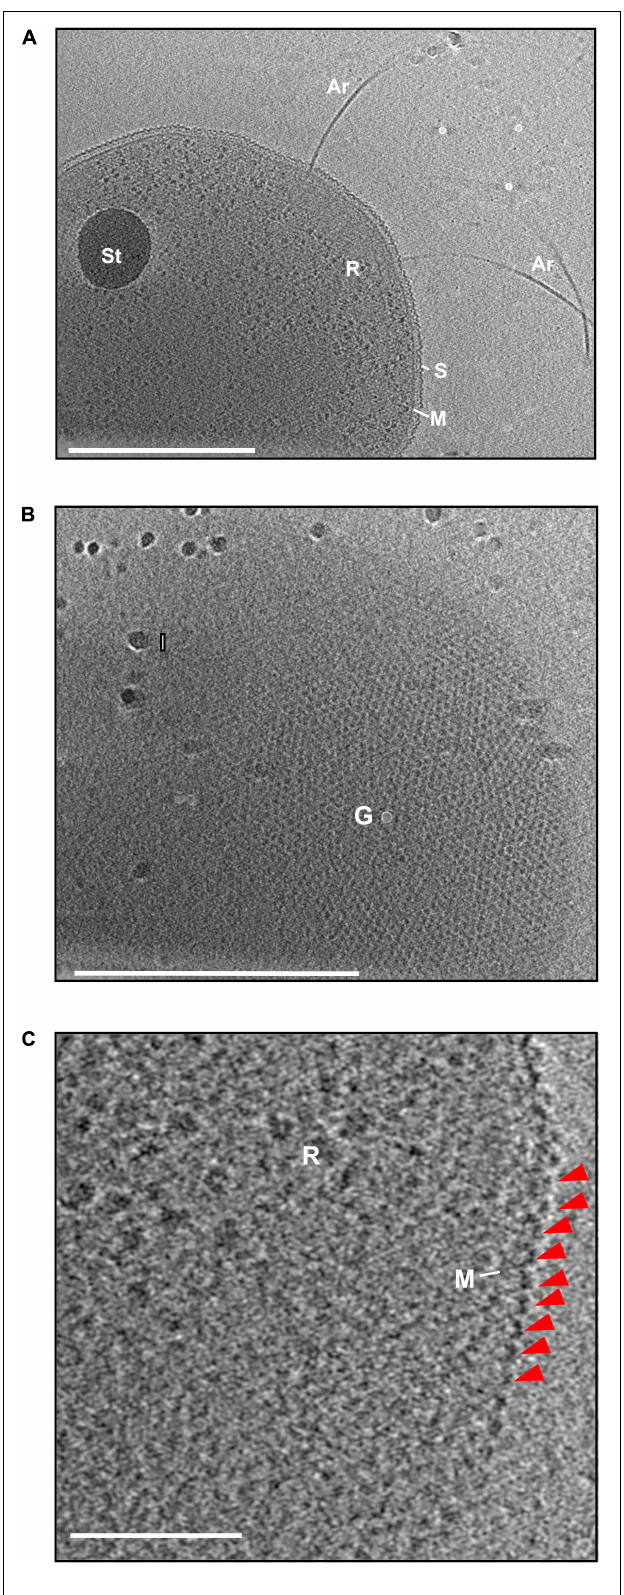
FIGURE 1 | Electron cryo microscopy and subtomogram slices of H. volcanii . (A) A slice through the reconstructed tomogram of H. volcanii . The subtomographic slice reveals the cells filled with ribosomes (R) and a possible storage granule (St). The cells are enveloped by the cytoplasmic membrane (M) and a S-layer (S). From the cells, the archaellar motility system, the archaellum, extends (Ar). Scale bar is 500 nm. (B) Extracted subtomographic slice, showing the top view of the cell. The cell body is covered by the hexagonal arranged S-layer lattice. Gold fiducial (G) and ice crystal (I) contaminations are indicated. Scale bar is 500 nm. (C) A magnified tomographic slice from (A) showing the characteristic dome-like shape the arranged S-layer protein indicated by a red arrow. Scale bar is 100